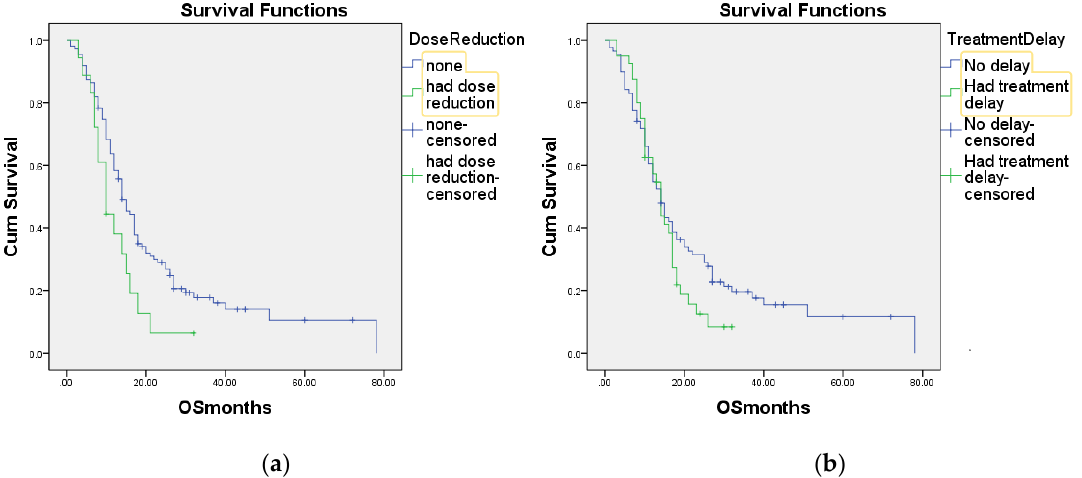
Figure 2. Overall survival in the ( a ) dose reduction group versus ( b ) no dose reduction group and treatment delay versus no treatment delay group.